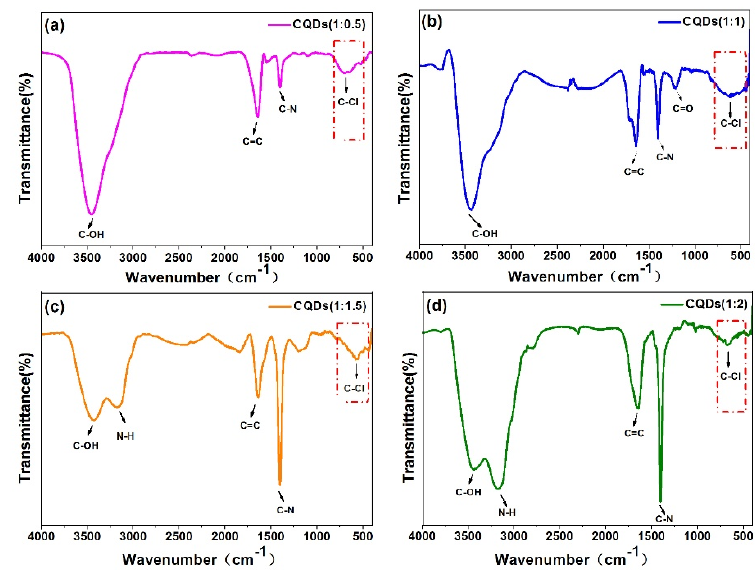
Figure 5. Fourier transform infrared (FTIR) spectra of CQDs (1:0.5) ( a ), CQDs (1:1) ( b ), CQDs (1:1.5) ( c ) and CQDs (1:2) ( d ).